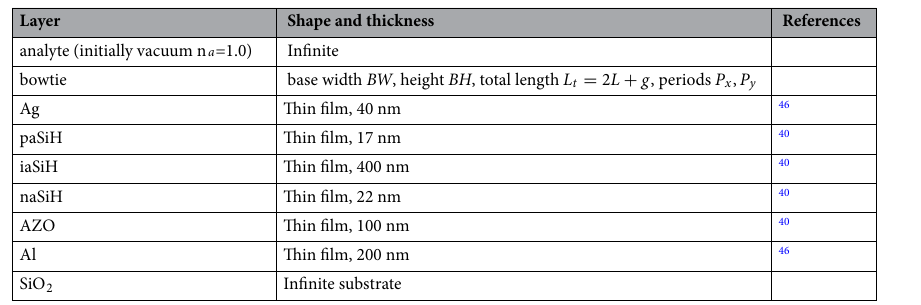
Table 1. Geometric and material arrangement of the